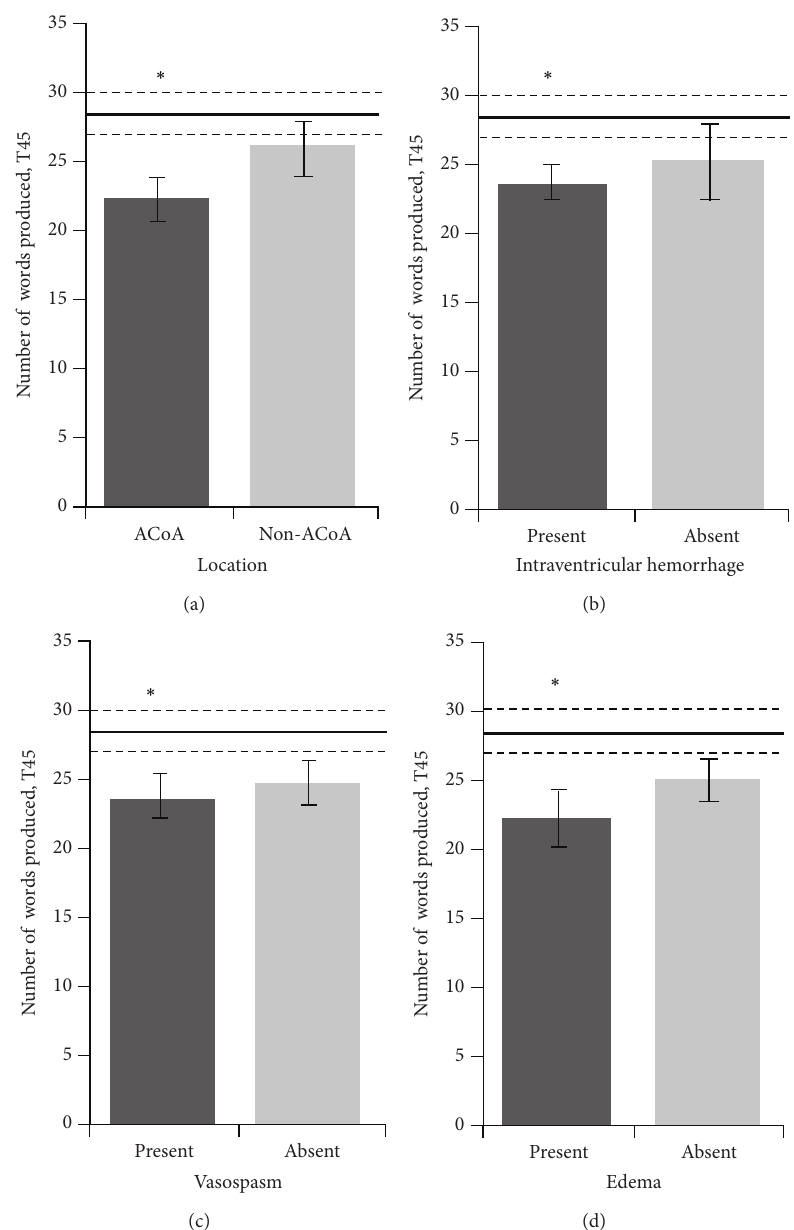
Figure 2: Number of words produced in the last 45 seconds of the phonemic fluency test by subgroups of coiled patients. Groups represented by the dark bars are those that were uniquely impaired in the last 45 seconds compared to healthy control subjects ( 𝑃 < .05 ). The bold horizontal line represents mean production in the control group; the dashed lines represent